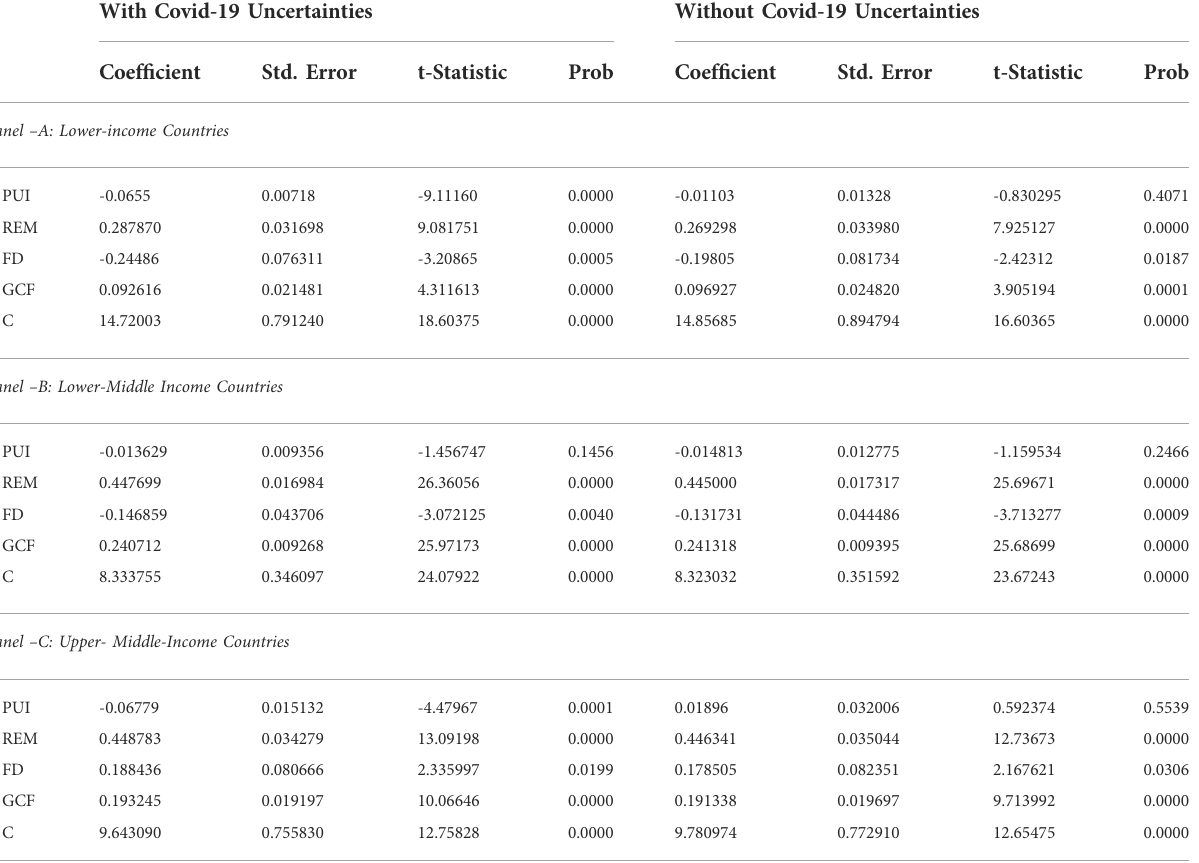
TABLE 6 Result of SUR estimation. With Covid-19